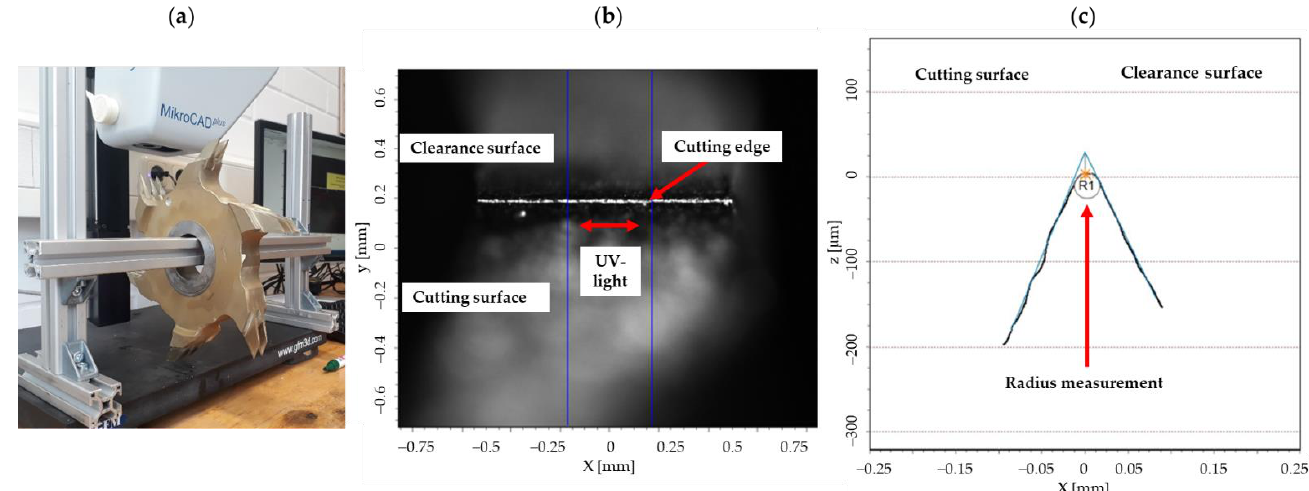
Figure 2. Microscopic measurement of the cutting edges to determine the degree of sharpness; ( a ) shows one of the examined cutter segments, ( b ) illustrates the components of the cutting edge and the measuring range, ( c ) shows the software-based determination of the cutting-edge radius as an indicator for the cutter wear.